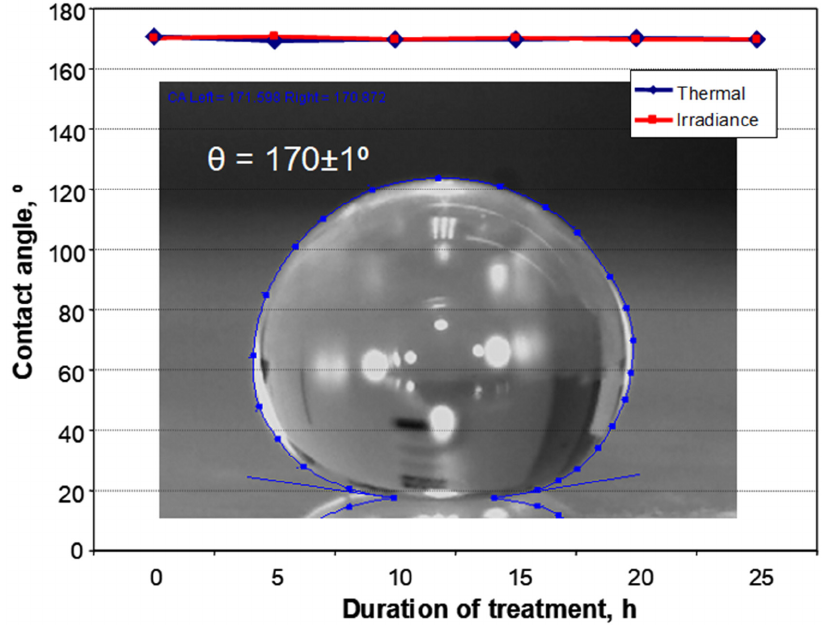
Figure 5. Stability of superhydrophobicity of the trilayer composite: contact angle after thermal and irradiance treatment for different time intervals. The inset shows the characteristic digital photograph Polymers 2021 , 13 , 3439 of the magnified 5 µ L water droplet on the surface of the trilayer composite.